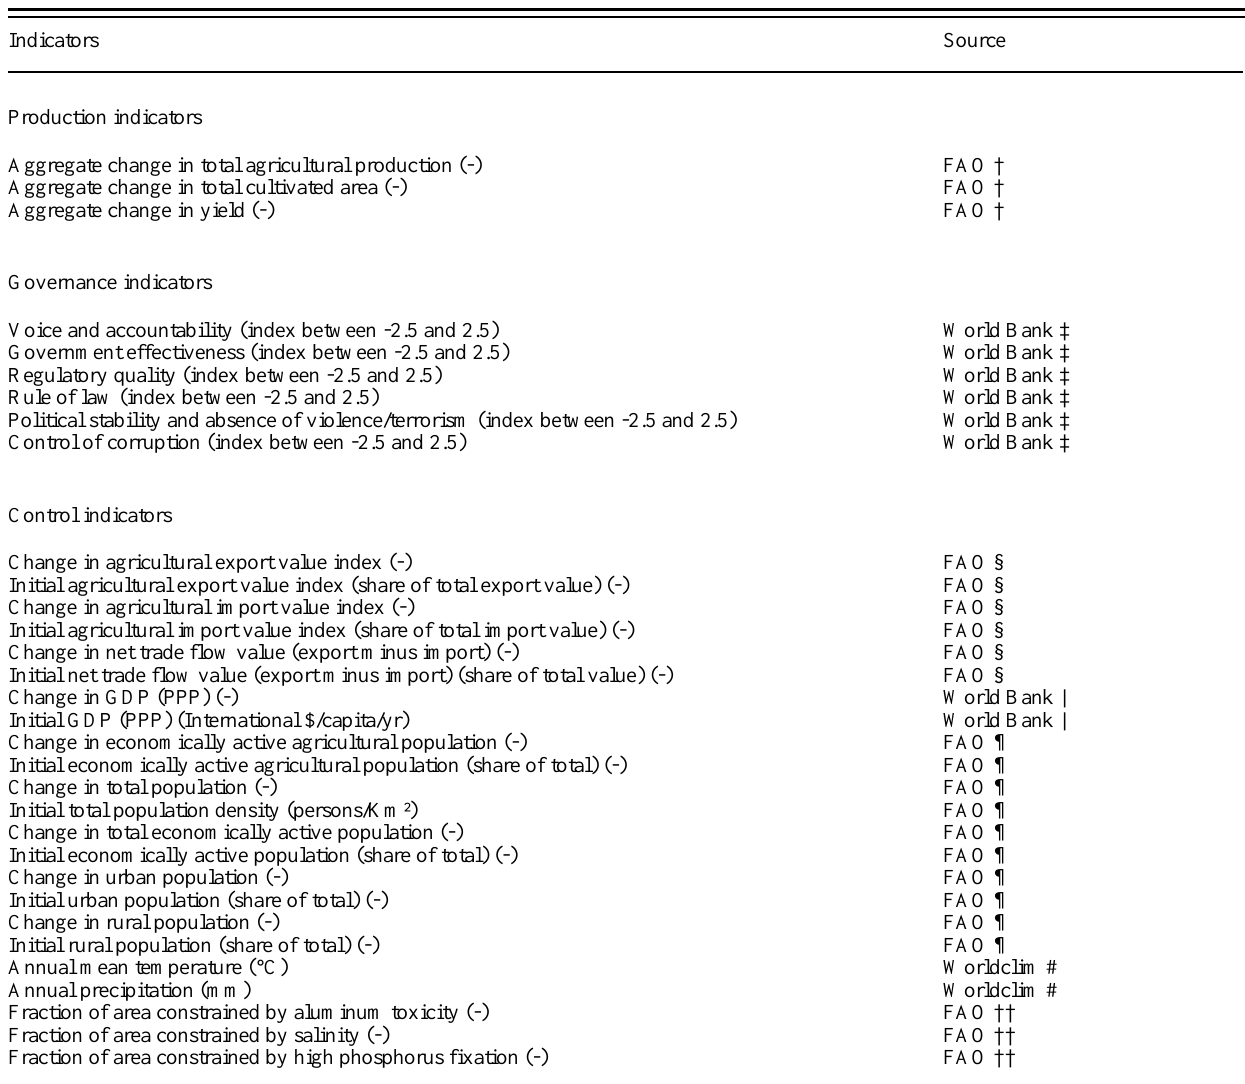
Table 1. Production, governance, and control